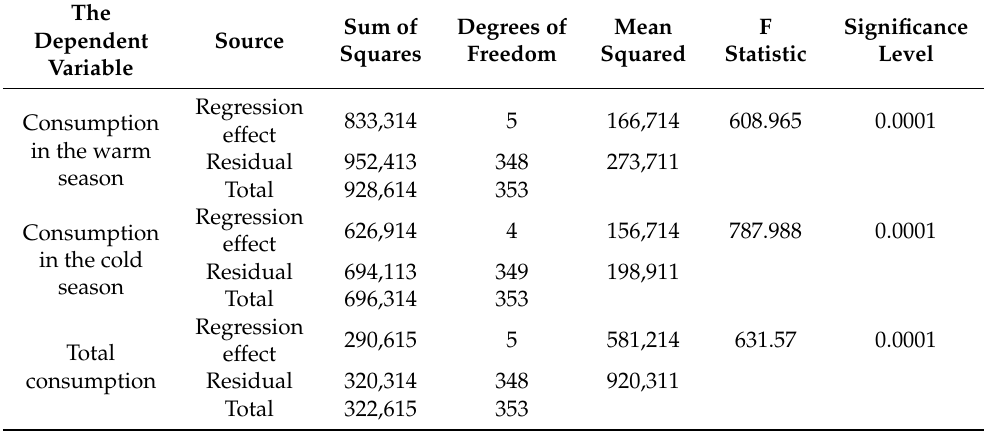
Table 6. Analytical statistics of linear regression of water consumption. Table 7. Variance analysis of linear regression of water